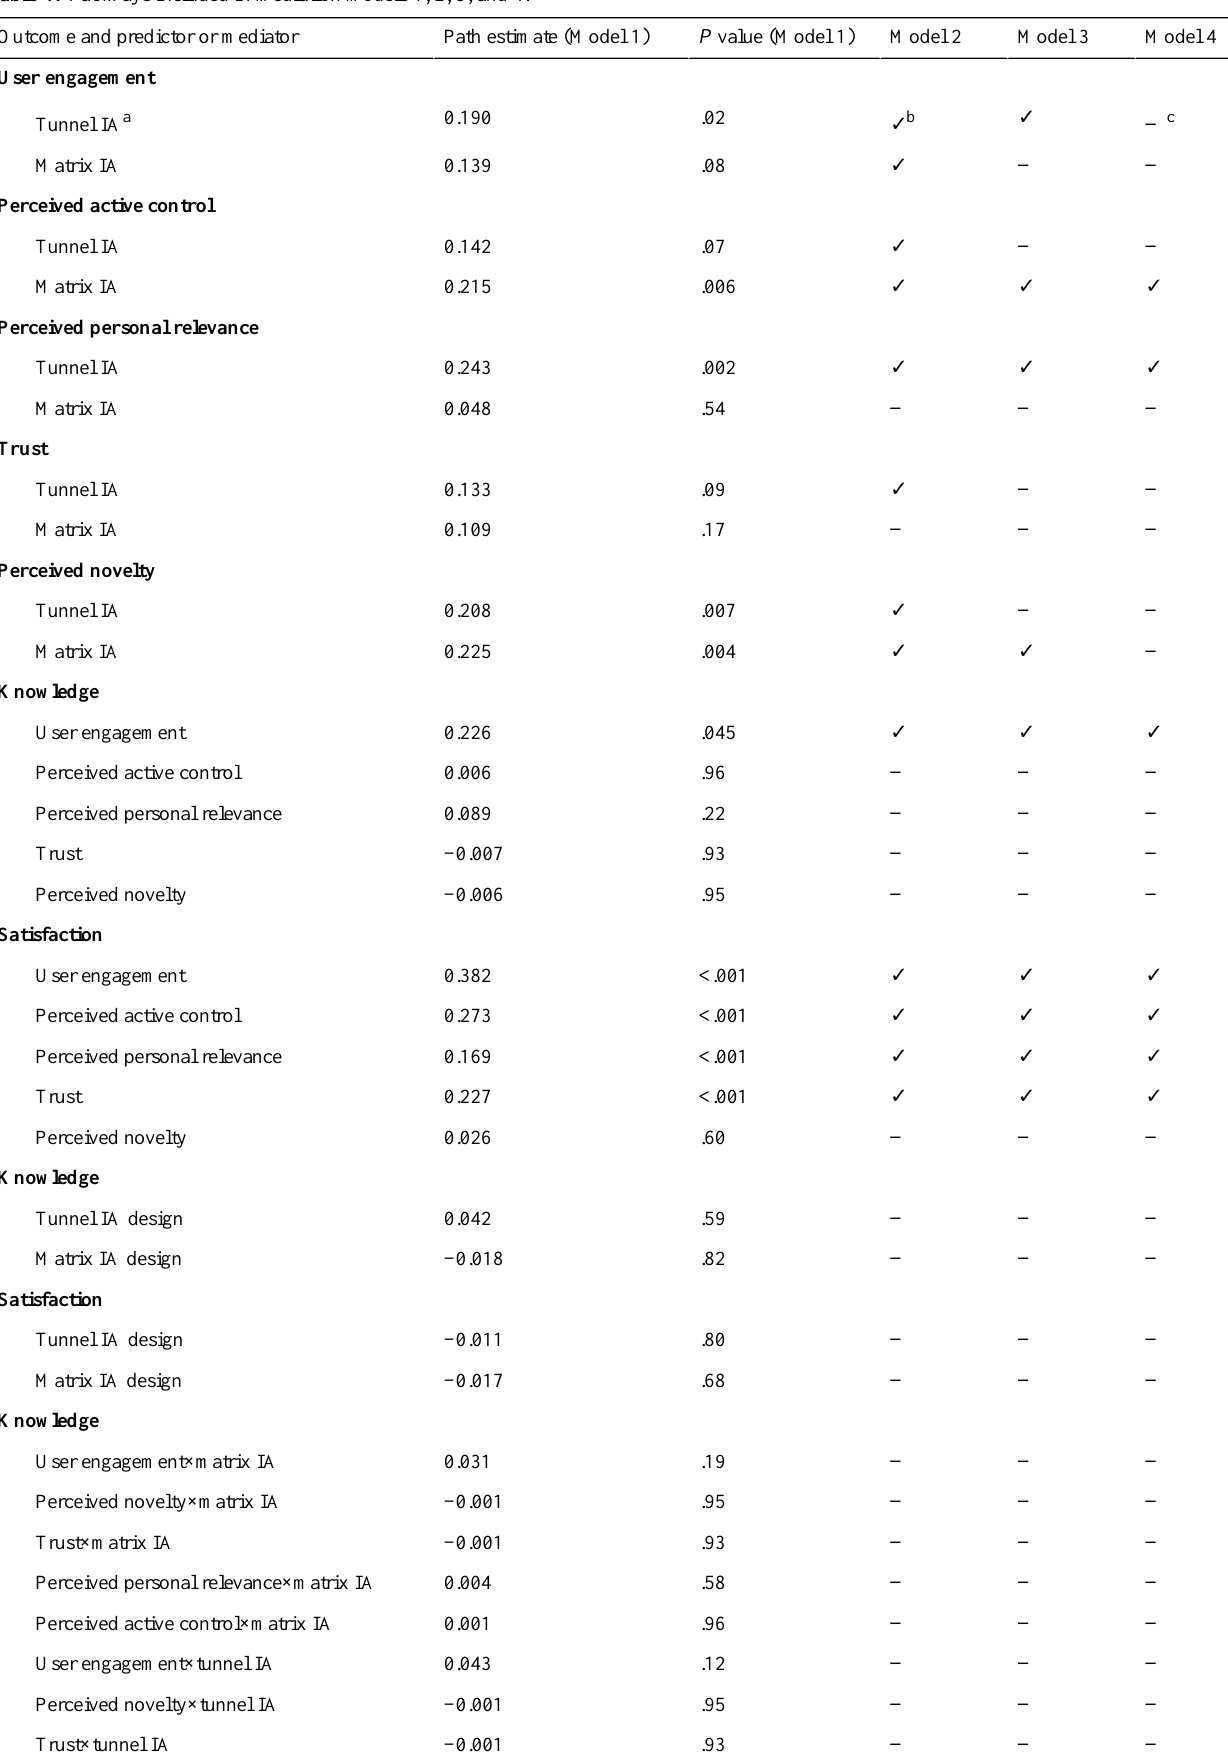
Table 4. Pathways included in mediation models 1, 2, 3, and